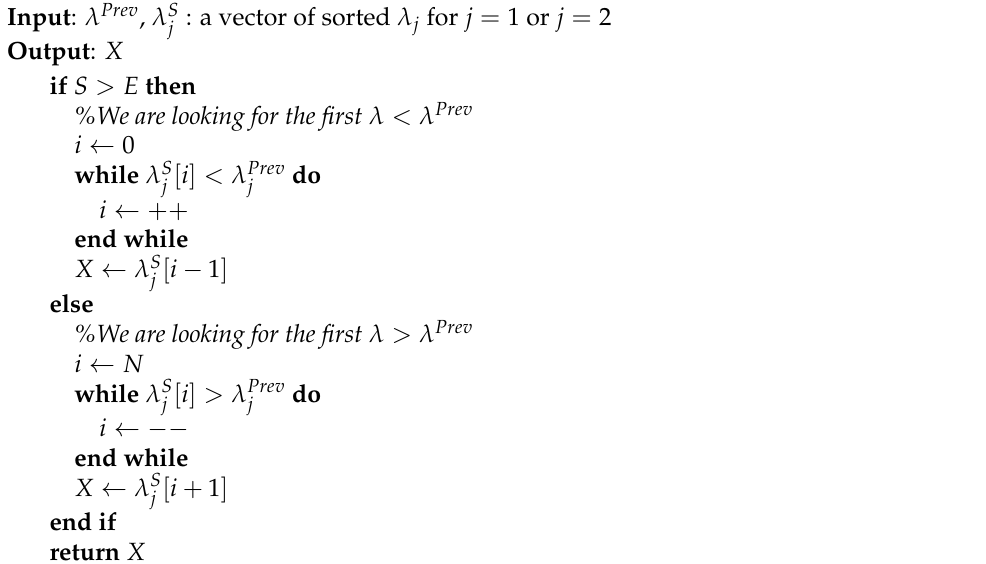
for j = 1 or j = 2 j